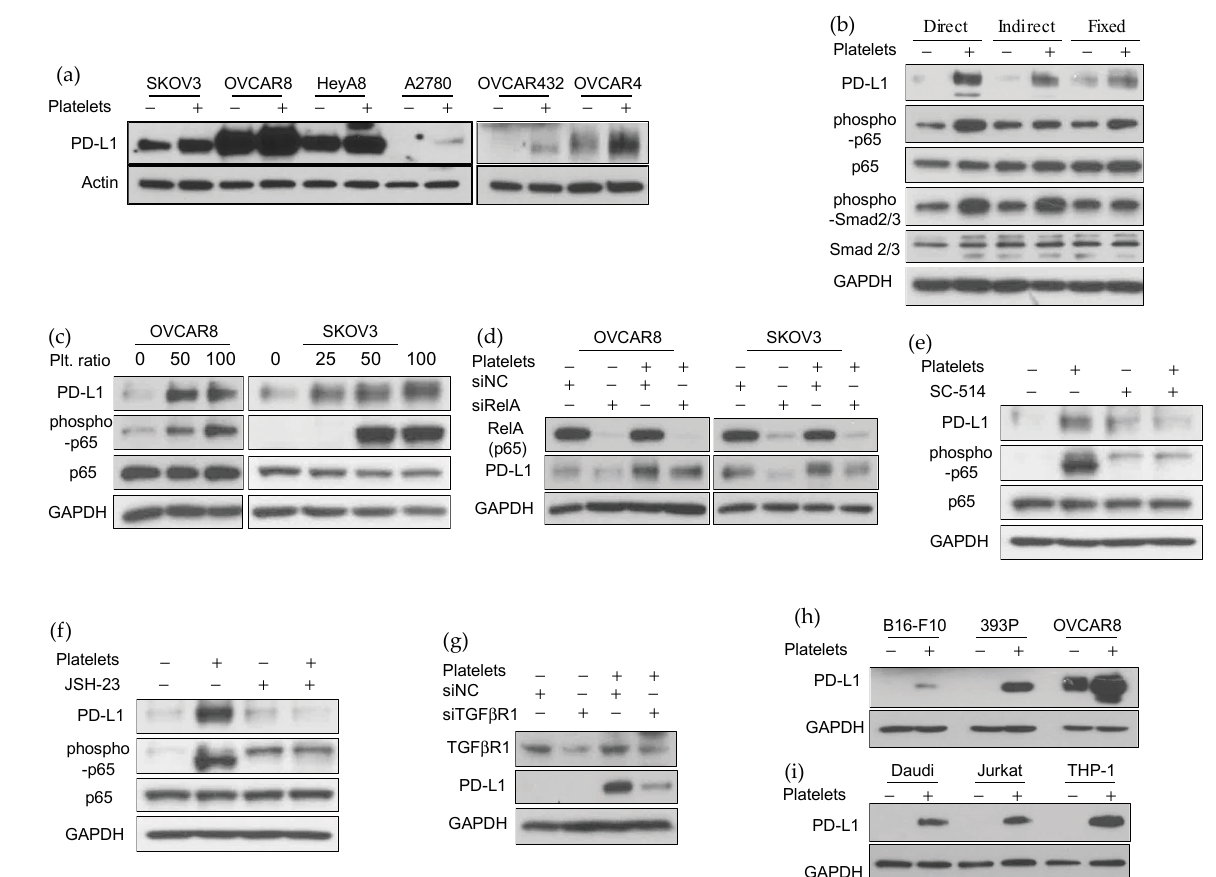
Figure 3. Platelets increase PD-L1 expression through NF- κ B and TGF β R1/Smad signaling. ( a ) Western blot analysis of PD-L1 in various human ovarian cancer cells at the baseline and after co-incubation with platelet at a ratio of 1:100 (number of cancer cells to platelets). The protein band representing β -Actin was used as a loading control. The data are representative of three independent experiments. ( b ) Western blot analysis of whole-cell lysate prepared from cancer cells after direct incubation with washed platelets, indirect exposure to platelets separated via a membrane in a transwell chamber, or incubation with paraformaldehyde-fixed platelets. Protein bands representing GAPDH and total p65 and Smad2/3 were used as loading controls. The data are representative of three independent experiments. ( c ) Western blot analysis of whole-cell lysate from OVCAR8 and SKOV3 cells co-incubated with platelet at a ratio of 1:25, 1:50, and 1:100 (number of cancer cells to platelets). Protein bands representing GAPDH and total p65 were used as loading controls. The data are representative of three independent experiments. ( d ) Effect of p65 gene knockdown using RelA siRNA on the platelet-induced PD-L1 expression in OVCAR8 and SKOV3 human ovarian cancer cells (representative of three independent experiments). NF- κ B blocking agents ( e ) 100 µM of SC-514 or ( f ) 50 µM of JSH-23 were added to ovarian cancer cells for 2 h before adding the platelets. ( g ) Effect of TGF β R1 gene knockdown on the platelet-induced PD-L1 expression in OVCAR8 human ovarian cancer cells (representative of three independent experiments). ( h , i ) Western blot analysis of PD-L1 in different murine and human cancer cell lines (B16-F10, 393P, OVCAR8, Daudi, Jurkat, and THP-1) baseline and after co-incubation with platelet at a ratio of 1:100 (number of cancer cells to platelets). The protein band representing GAPDH was used as a loading control (representative of three independent experiments). For original blots see supplementary File S1. For original densitometry results, see supplementary Table S1.